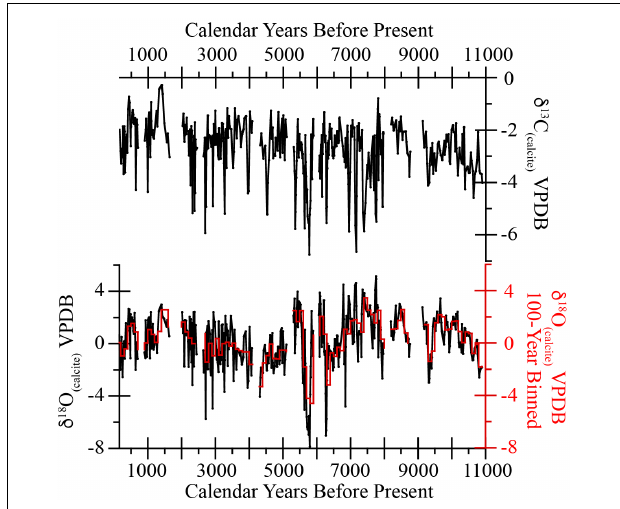
relative humidity, and/or other unforeseen isotopic imbalances (Gat, 1996; Leng and Marshall,